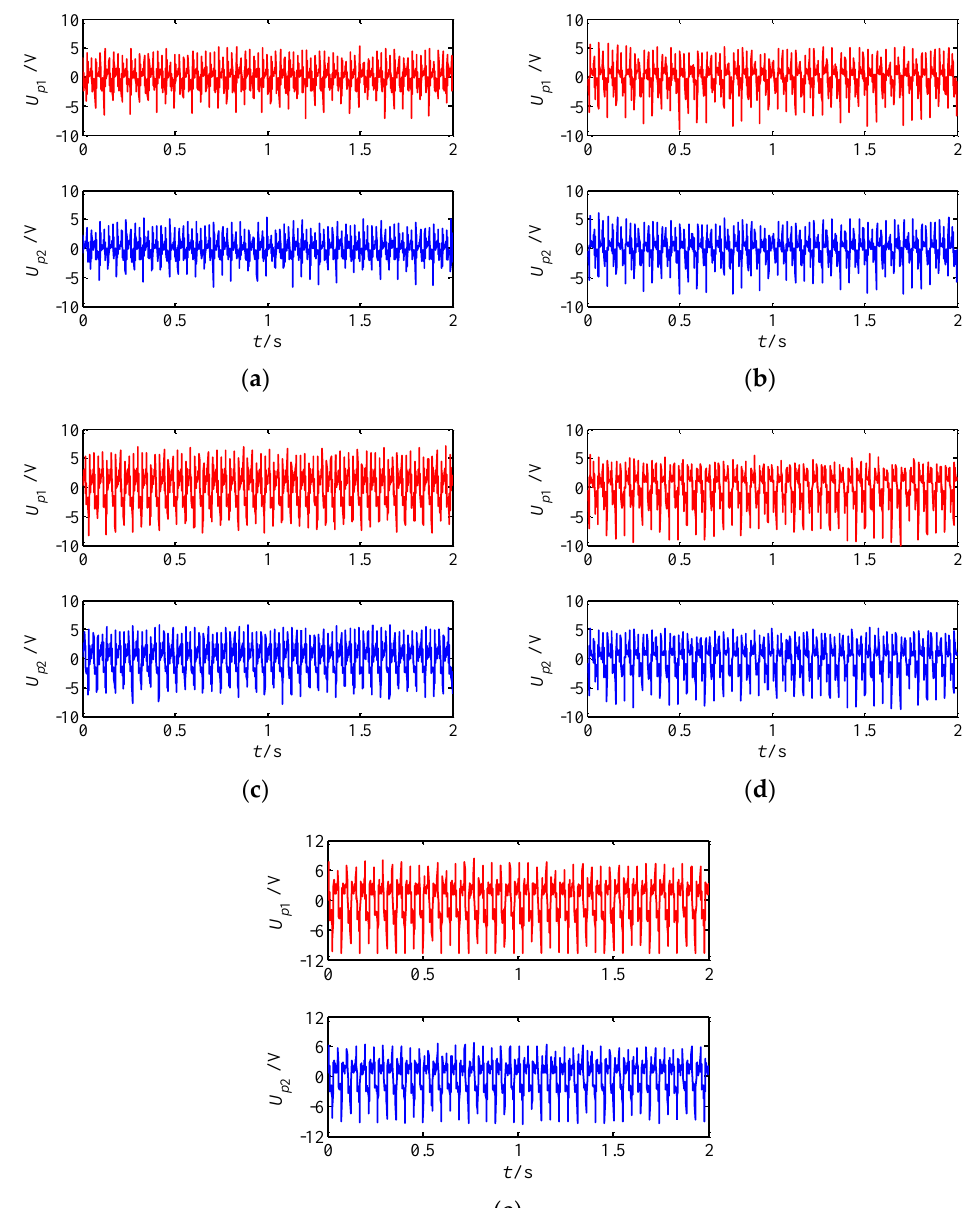
Figure 9. Test results of output voltage under continuous excitation. ( a ) R = 10 kΩ; ( b ) R = 20 kΩ; ( c ) R = 30 kΩ; ( d ) R = 40 kΩ; ( e ) R = 50 kΩ.